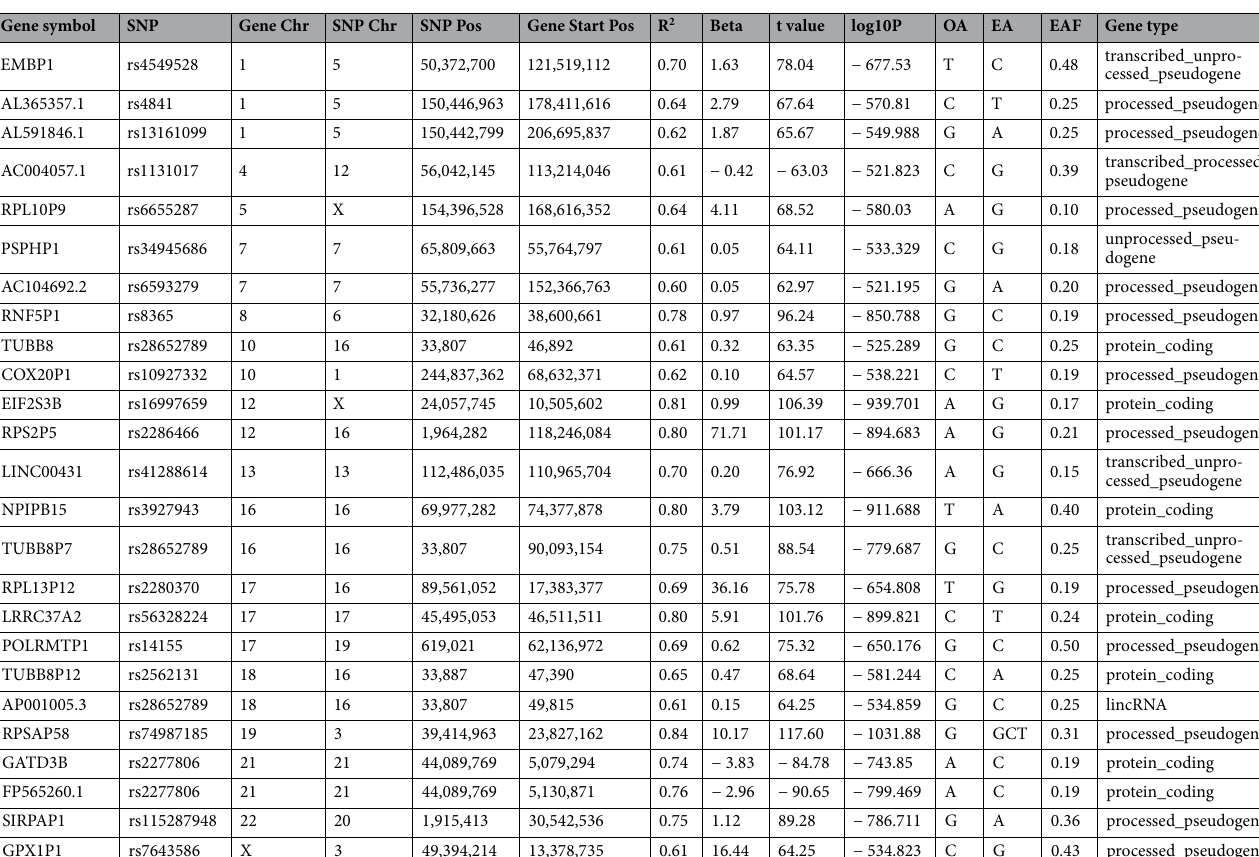
Table 3. Top 25 top trans-eQTLs ( p < 1e−12). EA effect allele, OA the other allele, EAF effect allele frequency, R 2 variance explained by the lead eQTL